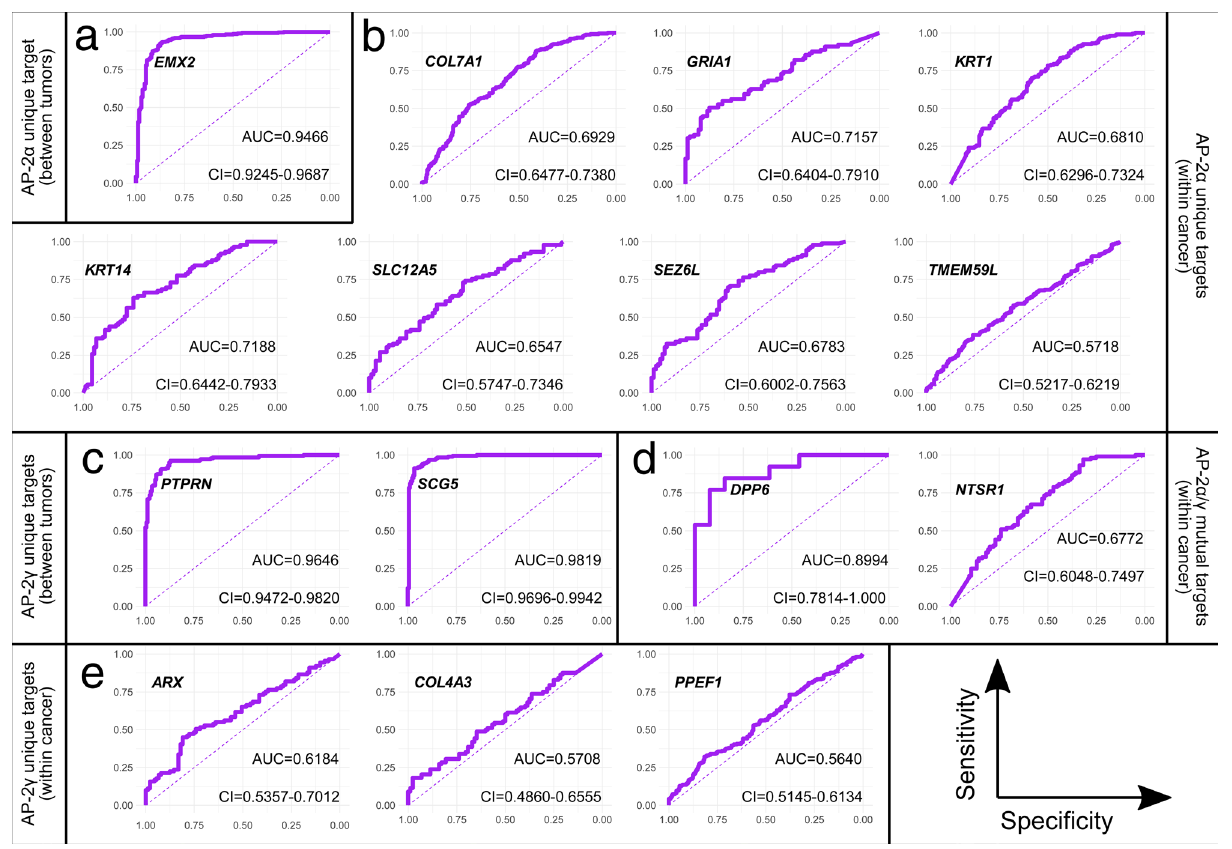
Figure 7. Receiver operating characteristic curves of genes that met the study requirements. ( a ) Unique for AP-2α (between-tumor comparison). ( b ) Unique for AP-2α (comparison within a specific cancer type). ( c ) Unique for AP-2γ (between-tumor comparison). ( d ) Mutual for AP-2α and AP-2γ. ( e ) Unique for AP-2γ (comparison within a specific cancer